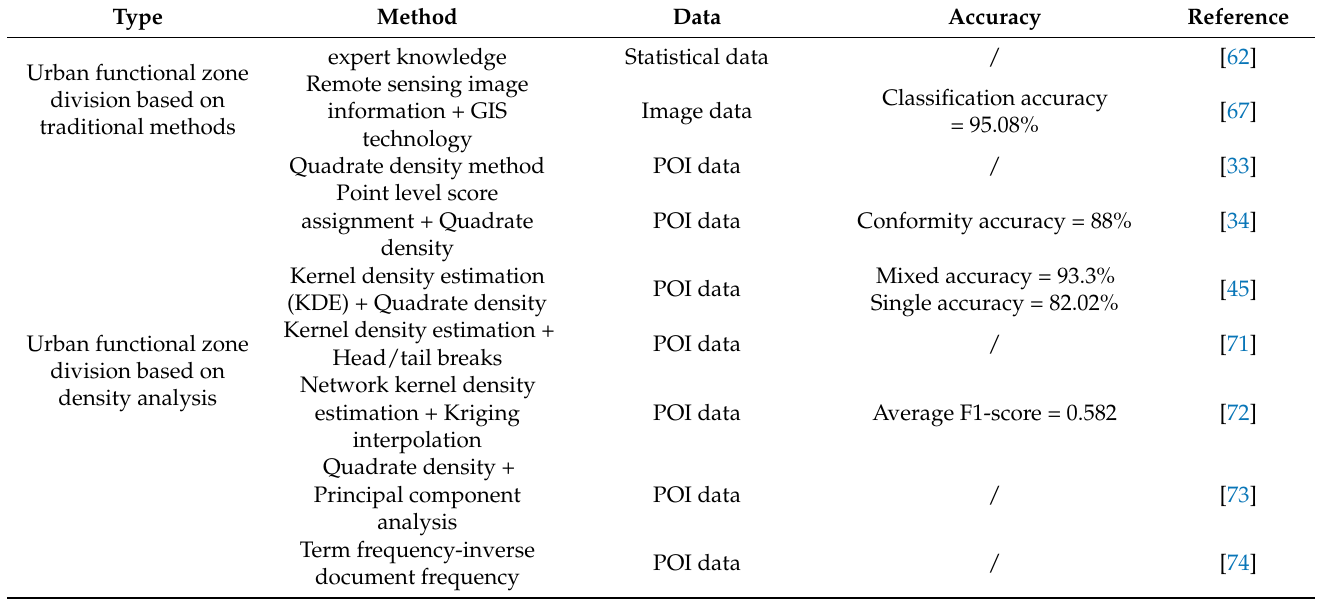
Table 1. Methods of identifying and dividing urban functional